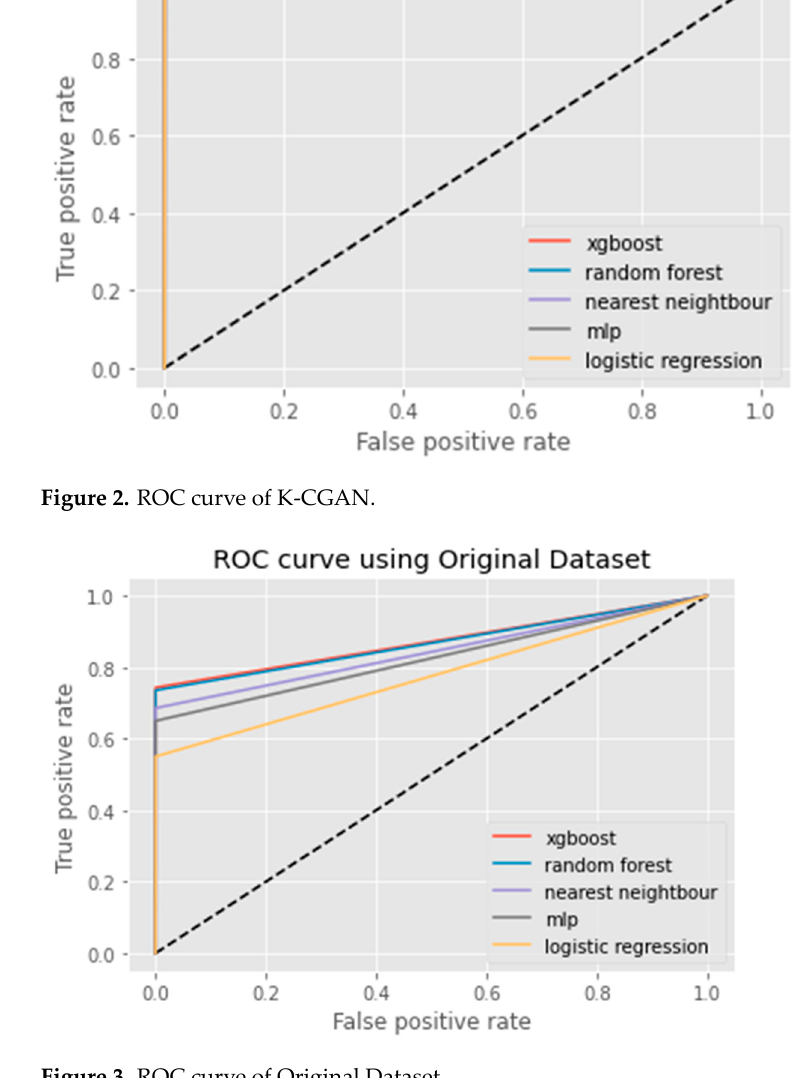
Figure 4. ROC curve using SMOTE. Figure 5. ROC curve using ADASYN.